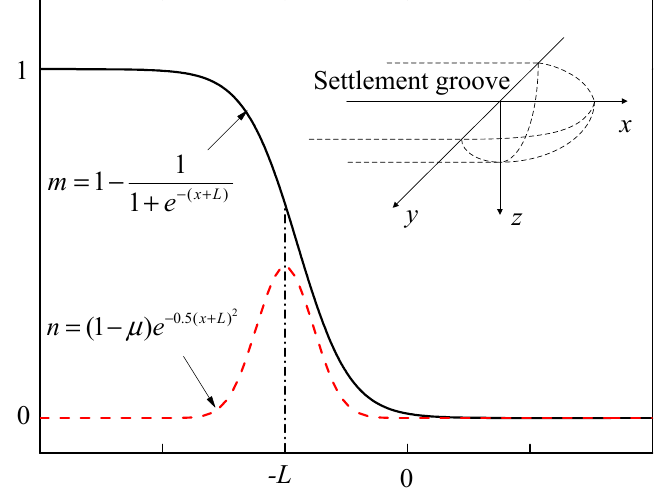
Figure 5. Overlaying coefficients in section direction and penetrating direction.